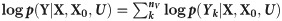
Generative model of Bayesian RSA.The covariance structure U shared across all voxels in an ROI is treated as a hyper-parameter of the unknown response amplitude β. For voxel k, the BOLD time series Yk are the only observable data. We assume Yk is generated by task-related activity amplitudes β⋅k (the k-th column of β), intrinsic fluctuation amplitudes β0⋅k and spatially independent noise ϵk: Yk = Xβk + X0
β0⋅k + ϵk, where X is the design matrix and X0 is the set of time courses of intrinsic fluctuations. ϵk is modeled as an AR(1) process with autocorrelation coefficient ρk and noise standard deviation σk. β⋅k depends on the voxel’s pseudo-SNR sk and noise level σk in addition to U: β⋅k ∼ N(0, (sk
σk)2
U). By marginalizing over β⋅k, β0⋅k, σk, ρk and sk for each voxel, we can obtain the likelihood function p(Yk|X, X0, U) and search for U which maximizes the total log likelihood logp(Y|X,X0,U)=∑knVlogp(Yk|X,X0,U) of the observed data Y for all nV voxels. The optimal U^ can be converted to a correlation matrix, representing the estimated similarity between patterns.